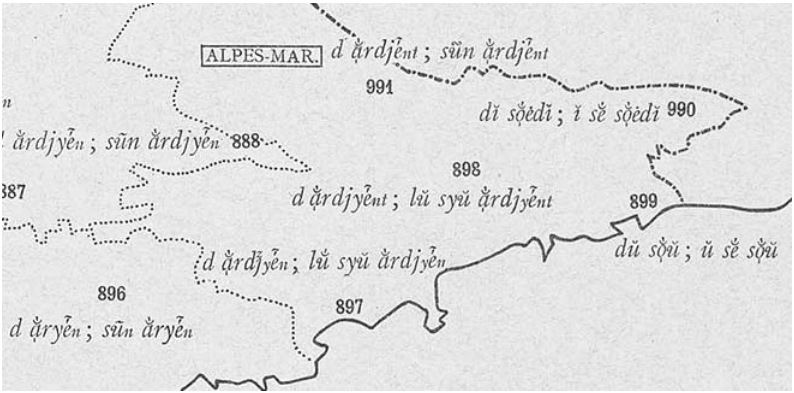
Figure 2. ALF 57: (gagner) de l’argent; ( . . . et que nous lui rendions) son argent . The map shows how mass nouns are licensed (before the semicolon) and whether possessives co-occur with articles (after the semicolon). Table 8. Summary of relevant data from ALF 57: (to gain) money ; Fr. (gagner) de l’argent ; with a simplified transcription.